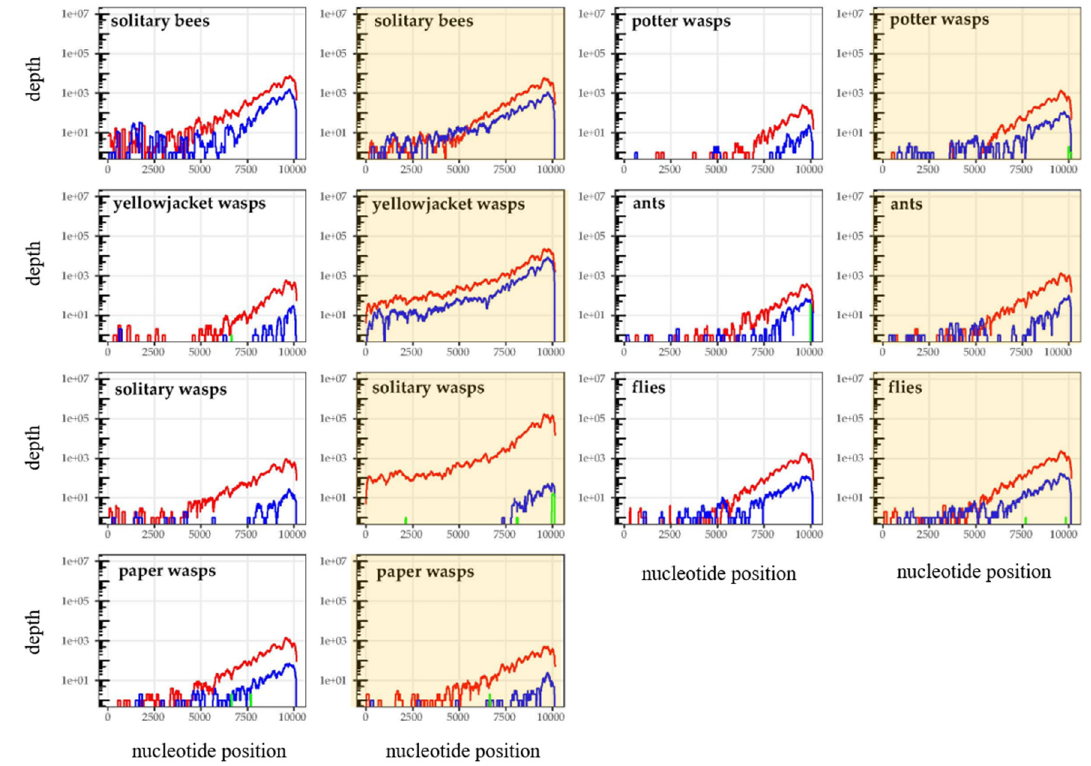
Figure 4. DWV coverage plots for all non-honey bee samples, pooled according to whether they were collected from with- Varroa (yellow background) or no- Varroa (white background) islands. DWV-A coverage is shown in red, DWV-B in blue and DWV-C in green. Each plot shows the total mapped DWV reads from the four individual samples per group.